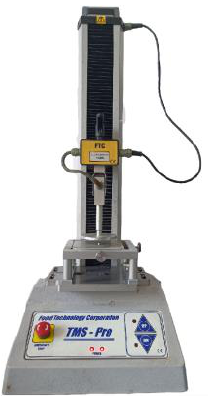
Figure 3. TMS-Pro texture analyzer.